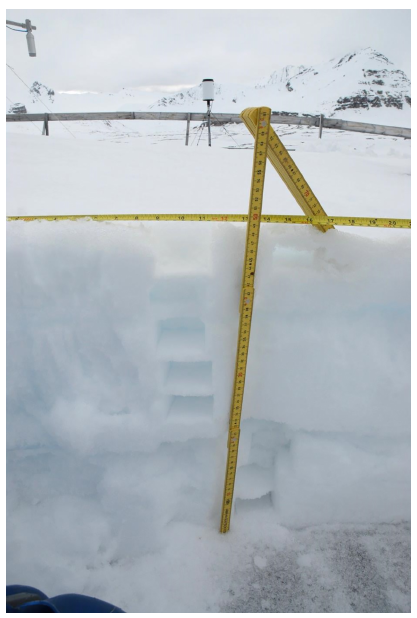
Figure E2. Snow profile taken on 9 May 2016, inside the Bayelva fenced area. The pockets/holes are the result of snow removal using a snow density cutter (100cm 3 ). Snow depth is 47cm above a basal ice layer at the point of measurement but ranges between 47 and 49cm. Measurements were taken to the left of the yellow folding rule (left and right profiles in Table E1). Ice layers are present 24– 28, 43–47 and 55–56cm above the basal ice layer, which is 15cm thick. Further data on temperatures, dielectric numbers and stratig- raphy can be found in Table E1.